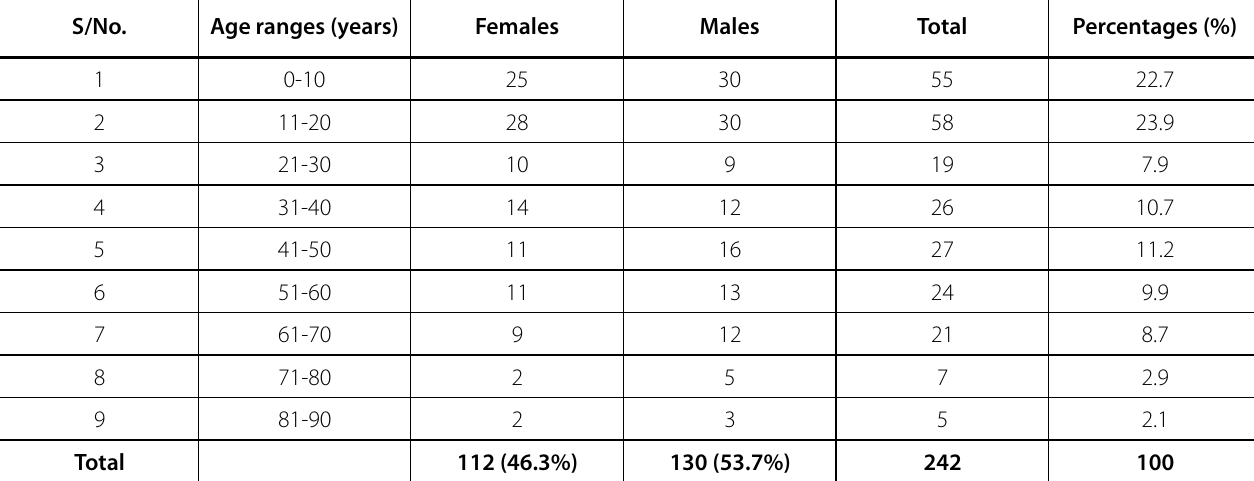
Table 2 . Age ranges and gender distribution of patients treated by the visiting cardiac teams. S/No.